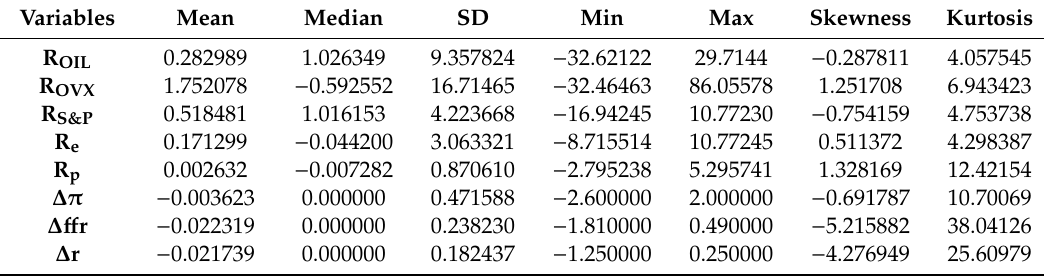
Table 5. Descriptive statistics for explanatory